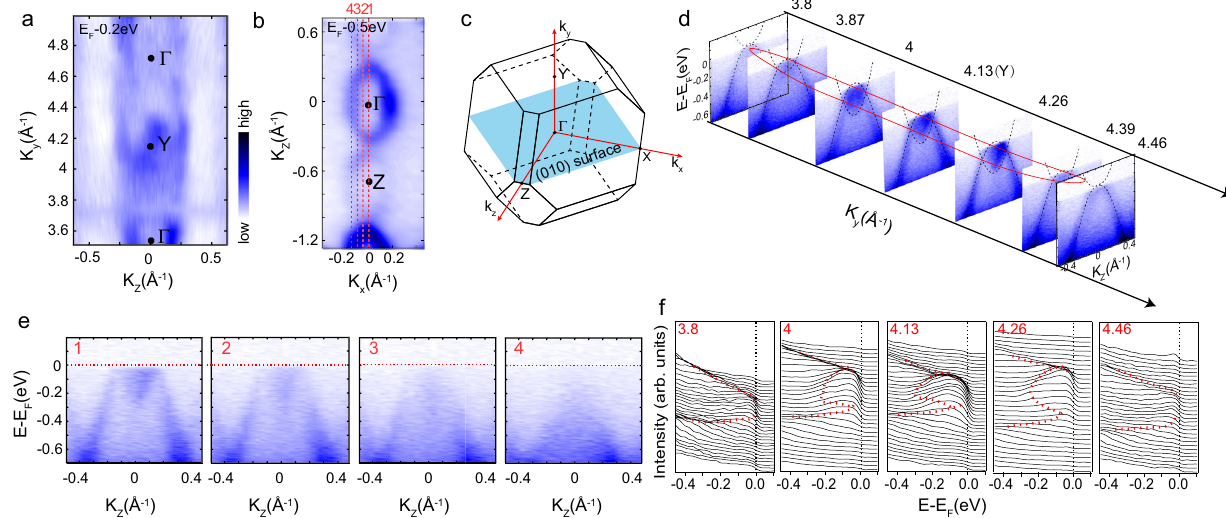
Fig. 4 Veri fi cation of topological nodal-line structure by ARPES measurements in the paramagnetic state of EuAs 3 . a Photon energy-dependent plot of photoemission intensity in the k z – k y plane taken at E F − 0.2 eV. b Photoemission intensity map of constant energy contours at 0.5 eV below E F in the k x – k z plane, the data were collected using photons with h ν = 55 eV. c The Brillouin zone (BZ) of EuAs 3 , with high-symmetry points and (010) surface labeled. d The band dispersions along k y direction probed by different photon energies. The calculations plotted by the black dotted curves superimposed on the experimental electronic structure. The red ellipse illustrates the topological nontrivial nodal loop schematically. e The band dispersions along cuts 1 – 4 as indicated in b , respectively. f Corresponding energy-distribution curves (EDCs) taken at different photon θ ≥ 60°, the intercept falls between − 1/8 and 1/8, while it falls between 3/8 and 5/8 for 30° ≤ θ < 60°. For the ε band, the